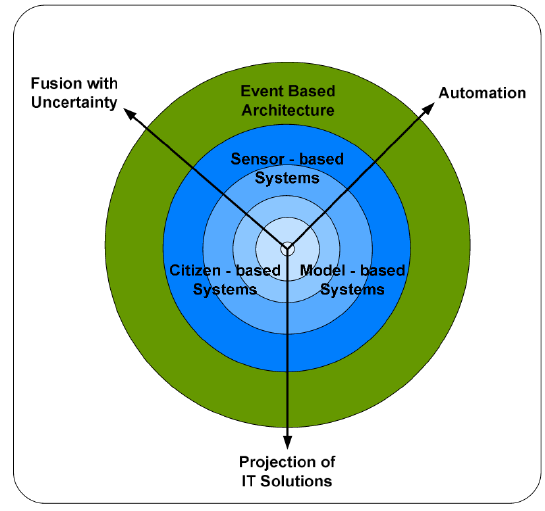
Figure 1. Theoretical challenges in sensor web research